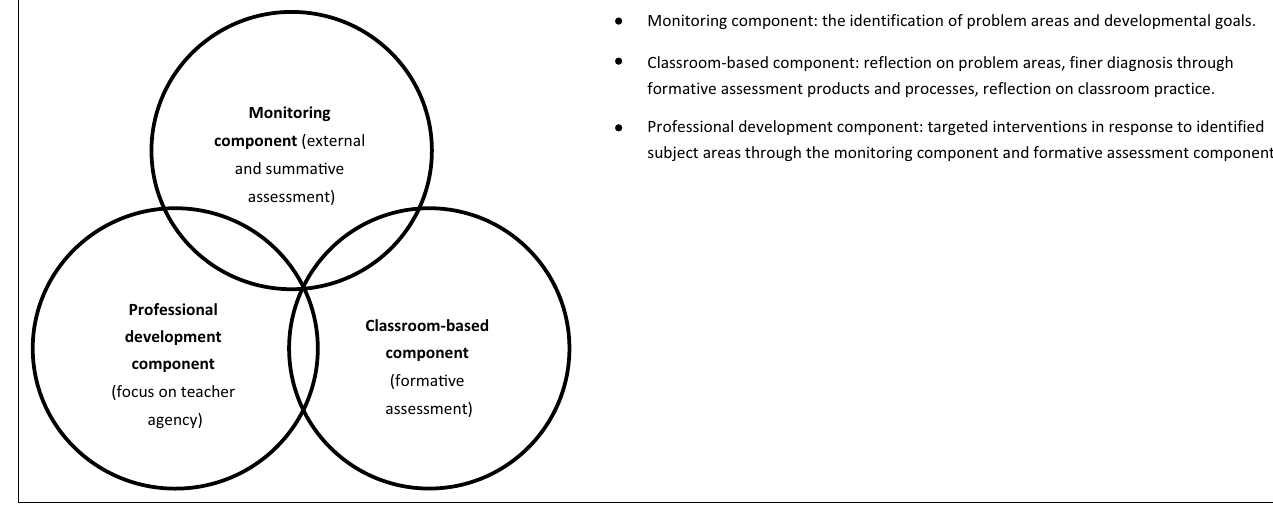
FIGURE 1: Model for system